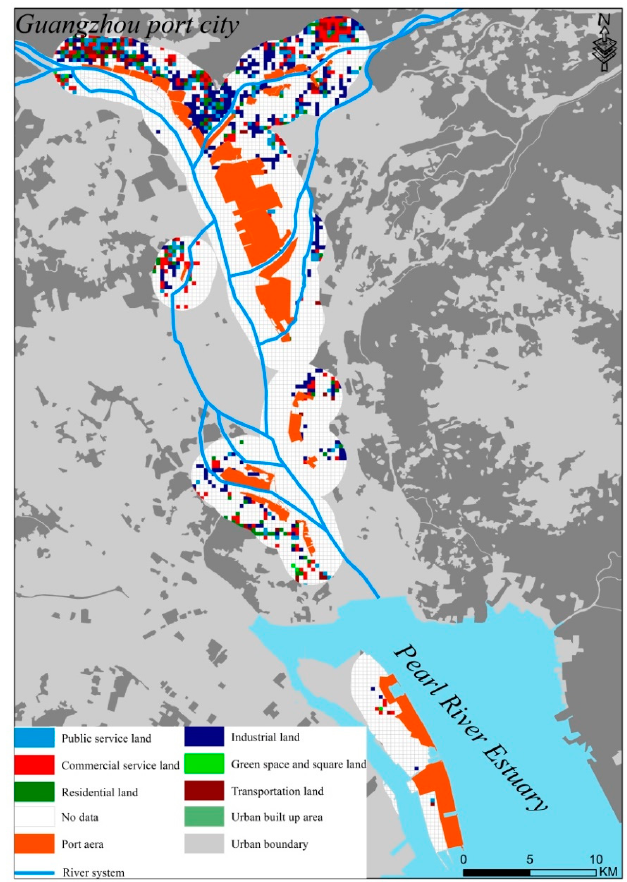
Figure 7. Distribution of urban functional areas on the Ningbo port–city interface (source: drawn by author).